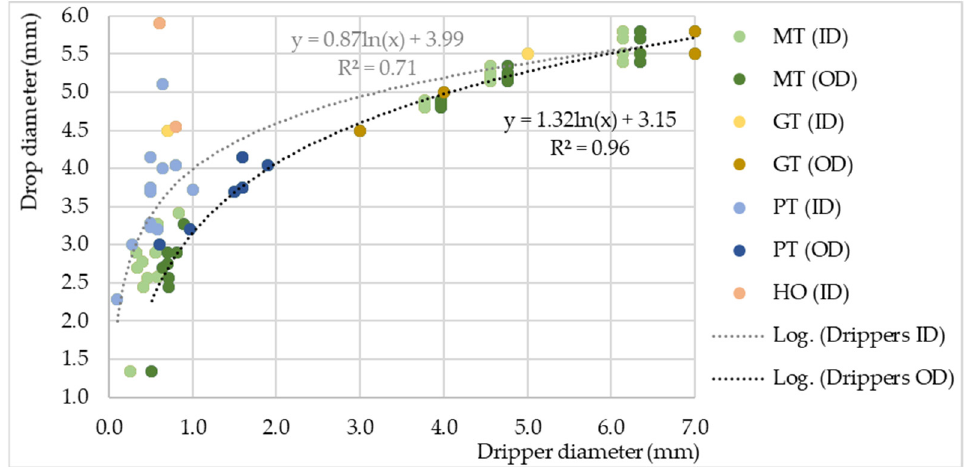
Figure 4. The influence of different types of drippers’ ID and OD on drop diameter size (GT—glass tubes, and HO—holes in boards and tubes). Note: drippers whose corresponding drops diameter size were modified by the action of air, vibrations and inserted threads, and drop and dripper diameters given in a range, were excluded from the analysis.